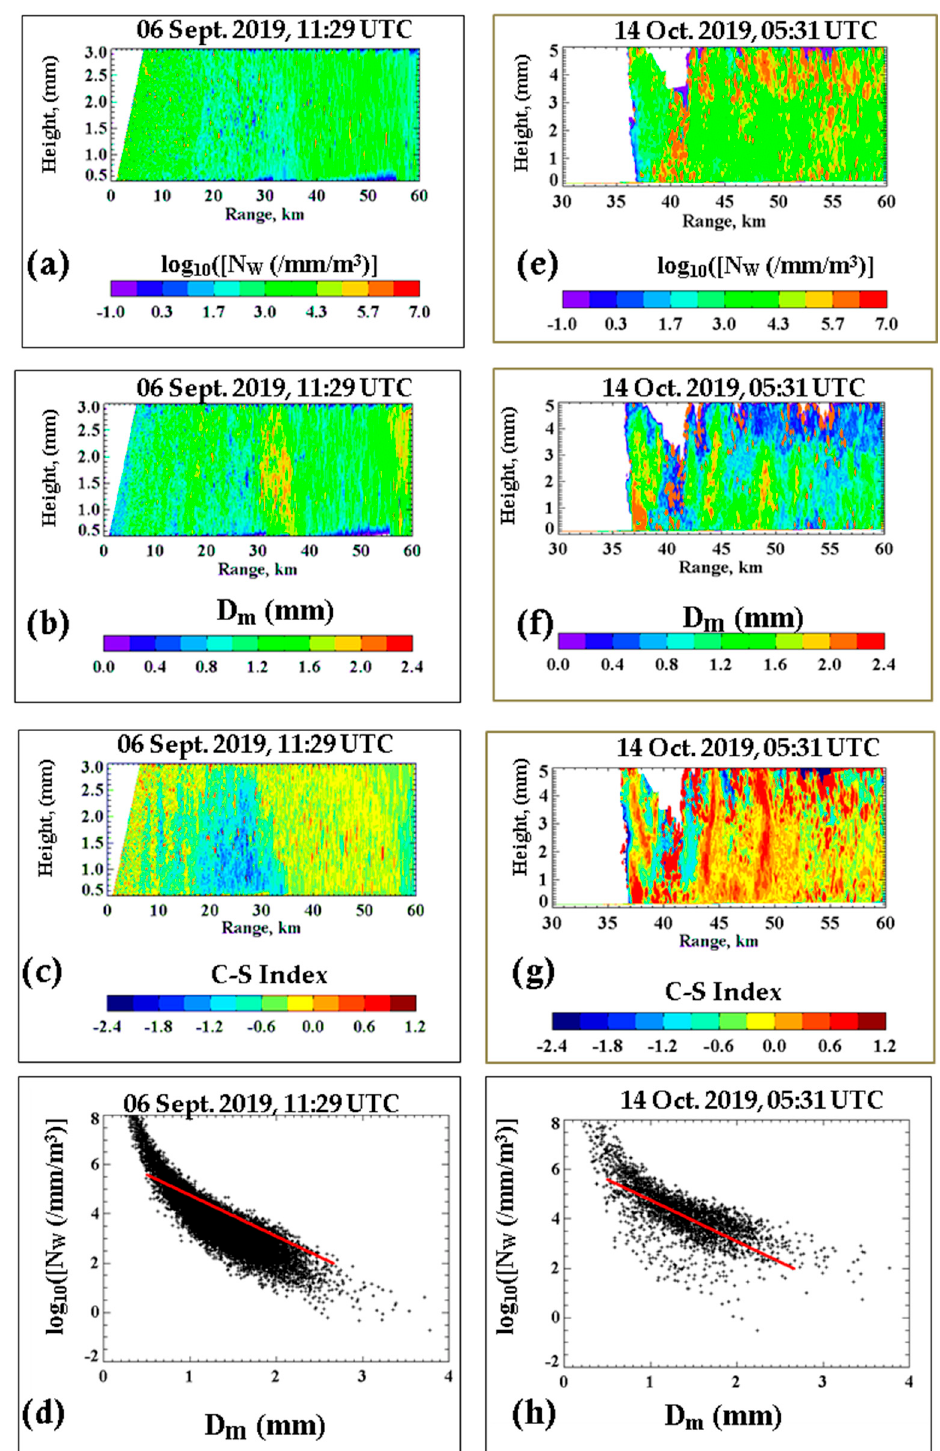
Figure 12. Retrievals from NPOL-RHI scans from the 6 September 2019 event (left panels) and from the 14 October 2019 event (right panels). ( a , e ) Show the retrieved N W , ( b , f ) show the retrieved D m , ( c , g ) show the convective-stratform (C-S) rain index values, and ( d , h ) show the N W versus D m for the two cases, for height range from 0.5 to 3 km.